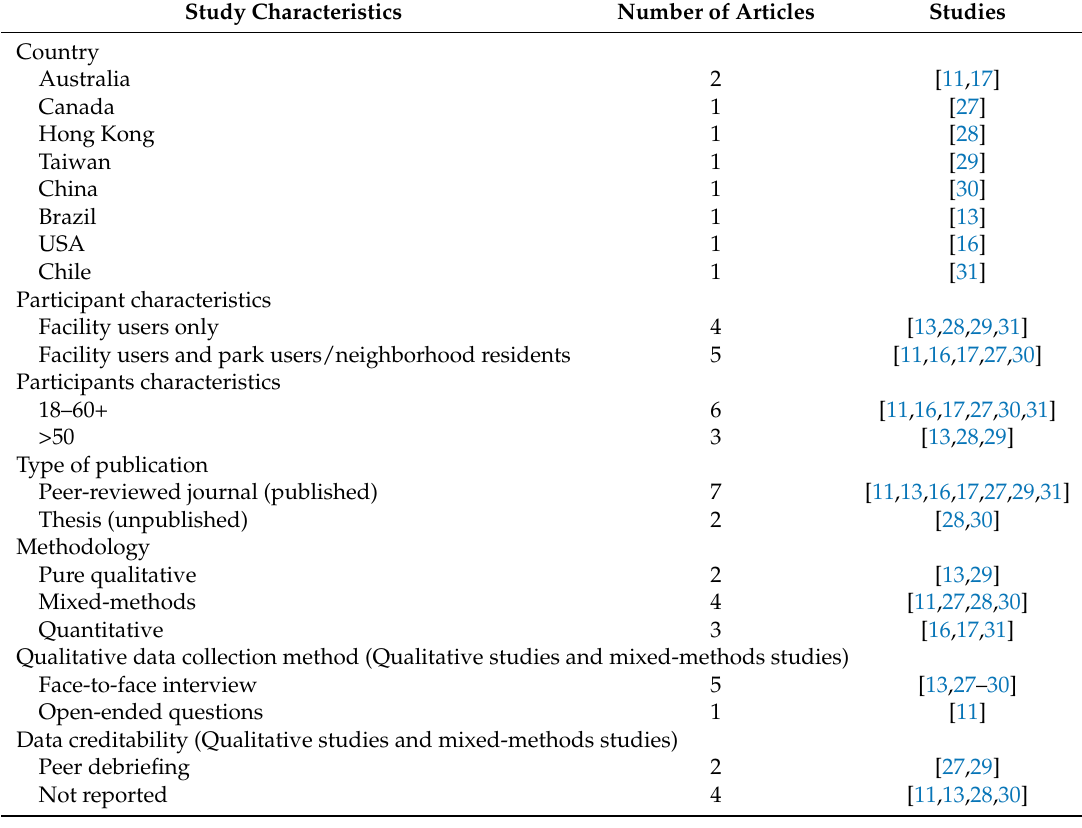
Table 1. Study characteristics and methodological aspects of the included